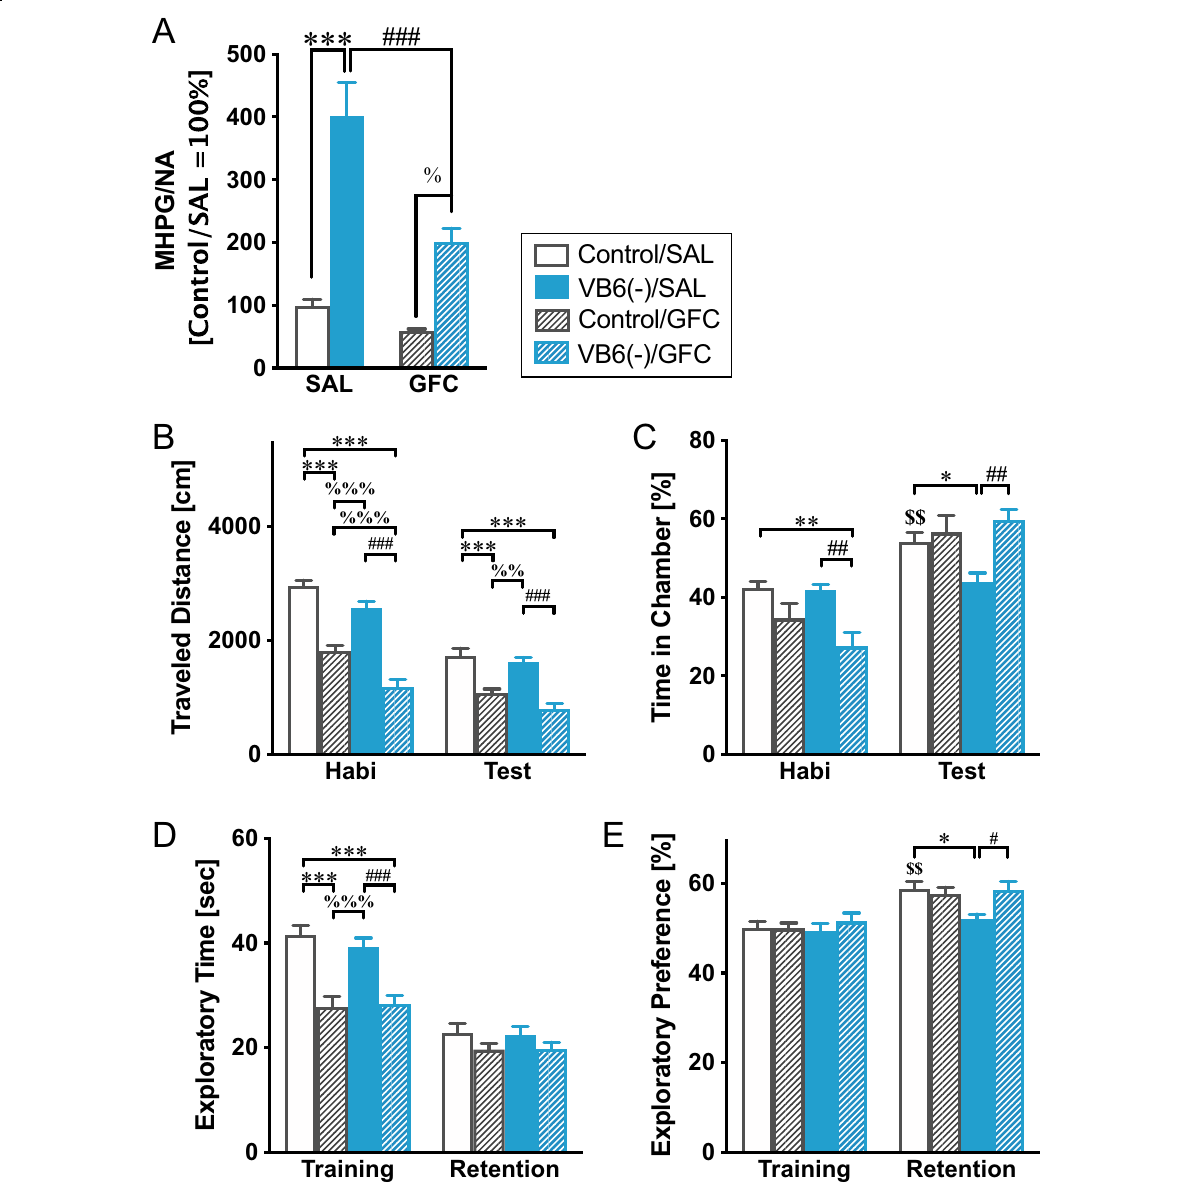
Fig. 5 Improvement of behavioral de fi cits in VB6-de fi cient mice by guanfacine treatment. VB6( − ) mice were administrated GFC during the last of 4 weeks of feeding with VB6-lacking diet. A NA turnover in the PFC were determined by HPLC. Two-way ANOVA: F Interaction(1,28) = 7.62, p < 0.05; F GFC(1,28) = 17.3, p < 0.001; F VB6(1,28) = 58.2, p < 0.001. *** p < 0.001, ### p < 0.001, and % p < 0.05 using Bonferroni ’ s multiple comparison test. In social interaction test, B traveled distance and C time spent in the chamber were measured ( n = 12). In the novel object recognition test, D exploratory time and E exploratory preference were determined (n = 12). Two-way ANOVA: B F Interaction(3,44) = 6.86, p < 0.001; F Session(1,44) = 147.8, p < 0.001; F Group(3,44) = 54.9, p < 0.001, C F Interaction(3,44) = 10.51, p < 0.001; F Session(1,44) = 71.7, p < 0.001; F Group(3,44) = 1.30, p > 0.05, D F Interaction(3,44) = 4.78, p < 0.01; F Session(1,44) = 111.6, p < 0.001; F Group(3,44) = 17.5, p < 0.001, and E F Interaction(3,44) = 1.07, p > 0.05; F Session(1,44) = 25.8, p < 0.001; F Group(3,44) = 4.00, p < 0.05. * p < 0.05, *** p < 0.001, # p < 0.05, ## p < 0.01, %% p < 0.01, %%% p < 0.001, and &&& p < 0.001 using Bonferroni ’ s multiple comparison test. $$ p < 0.01 compared with control/SAL mice between the habituation and the training session by Bonferroni ’ s multiple comparison test. The data were shown as mean ± SEM